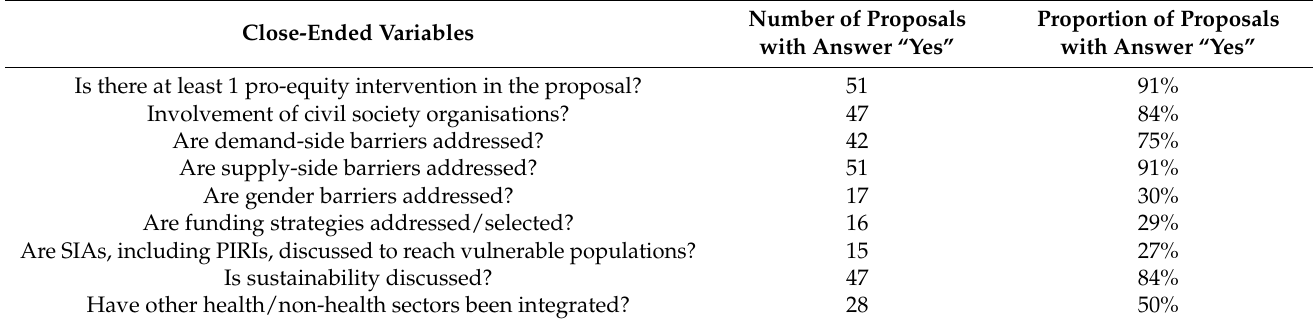
Table 2. Number and proportion of HSS proposals (out of 56) which addressed the close-ended variables (Yes or No response type) of the analytical